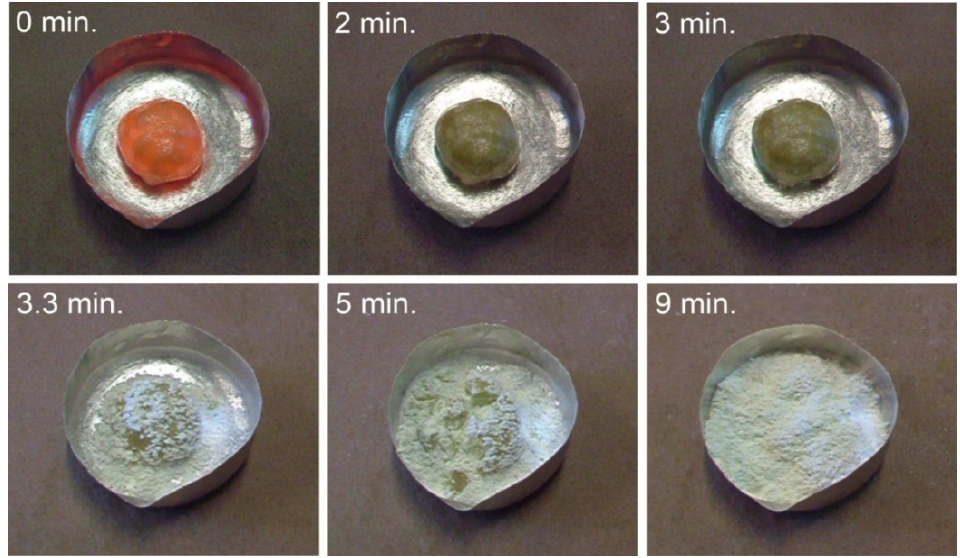
Figure 3. Polymorphic transition from β -C 2 S to γ -C 2 S, illustrating the complete self-disintegration over time.